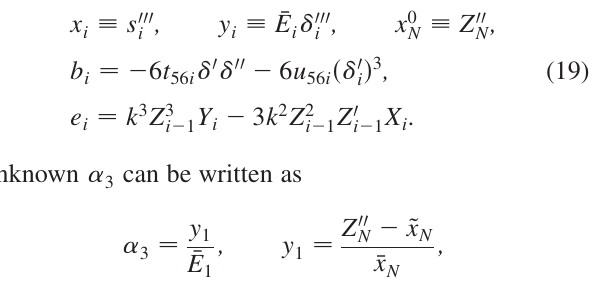
as a point in the parameter space ð X 1 ; 1 j =C near the working point at 2 2